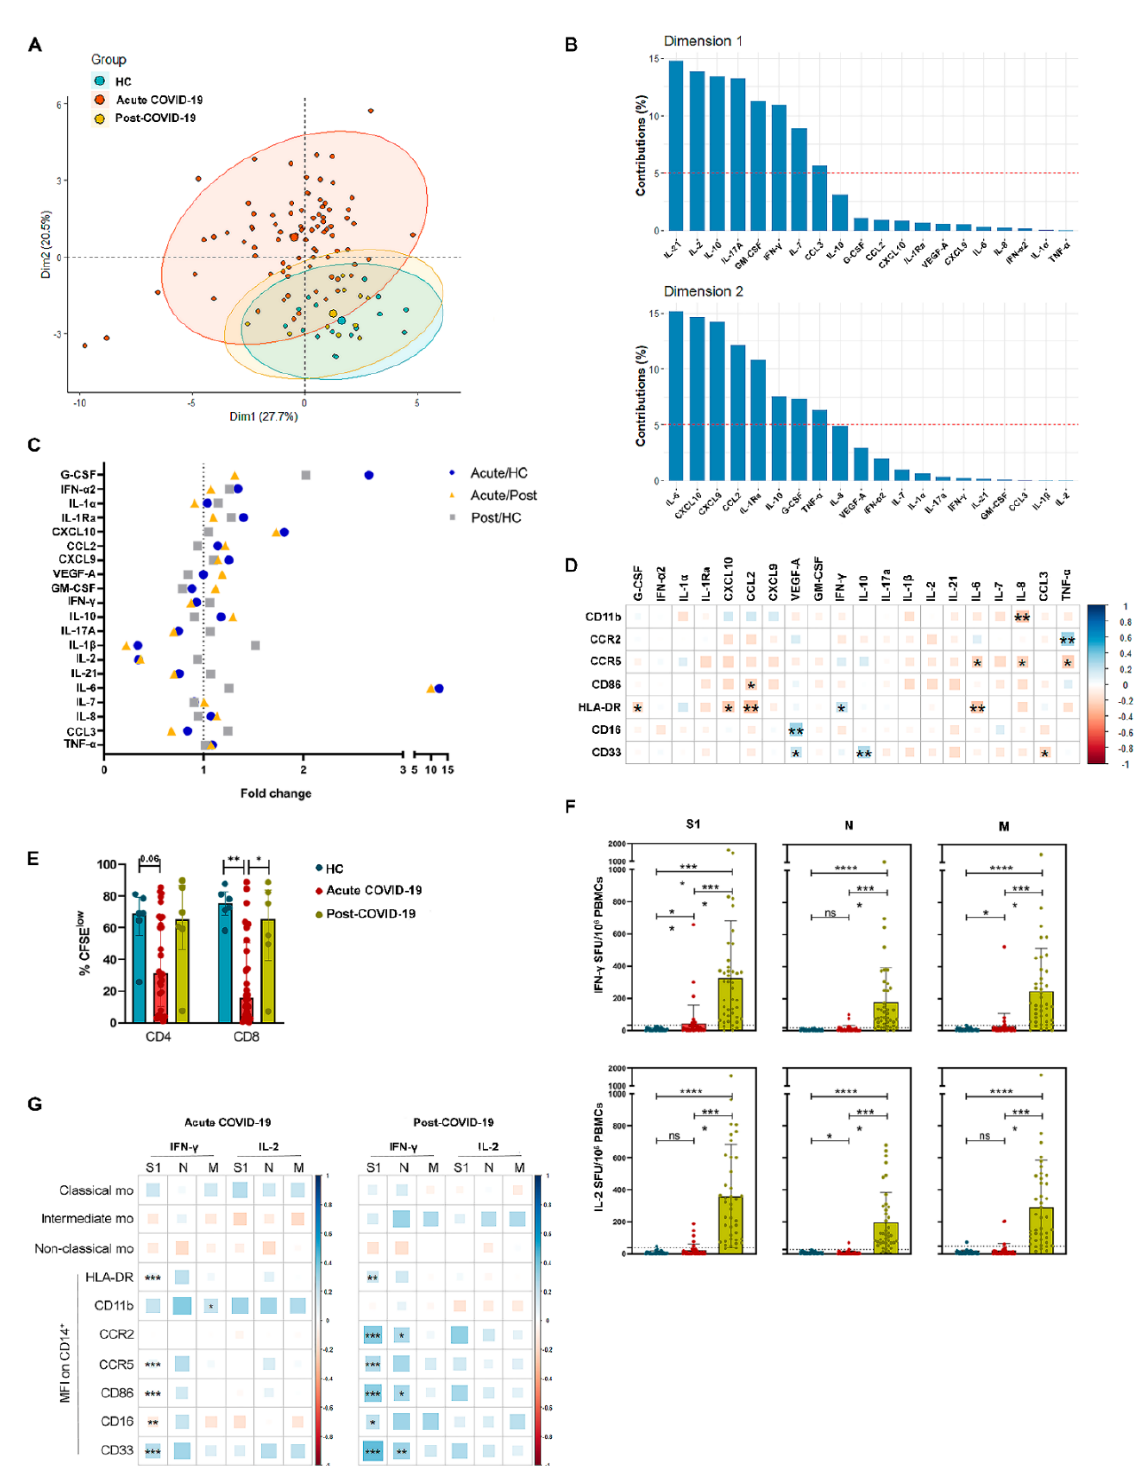
Figure 2. HLA-DR downregulation in monocytes correlates with higher plasma levels of IL-6, G-CSF, CXCL10, CCL2 and lower SARS-CoV-2-specific T cell response. ( A ) PCA of 20 cytokines in plasma from HC ( n = 16), acute ( n = 84) and post-COVID-19 ( n = 10) patients. Individual patient values (small points), mean (big point) and confidence interval of the mean (shadows) are represented. ( B ) Contribution of each cytokine to PCA dimensions 1 and 2. Dashed line represents the mean of all cytokine contributions. ( C ) Fold changes of median log-transformed values of plasma cytokines analyzed in HC, acute and post-COVID-19 patients. Dotted line represents unchanged cytokine level. ( D ) Correlation analysis between